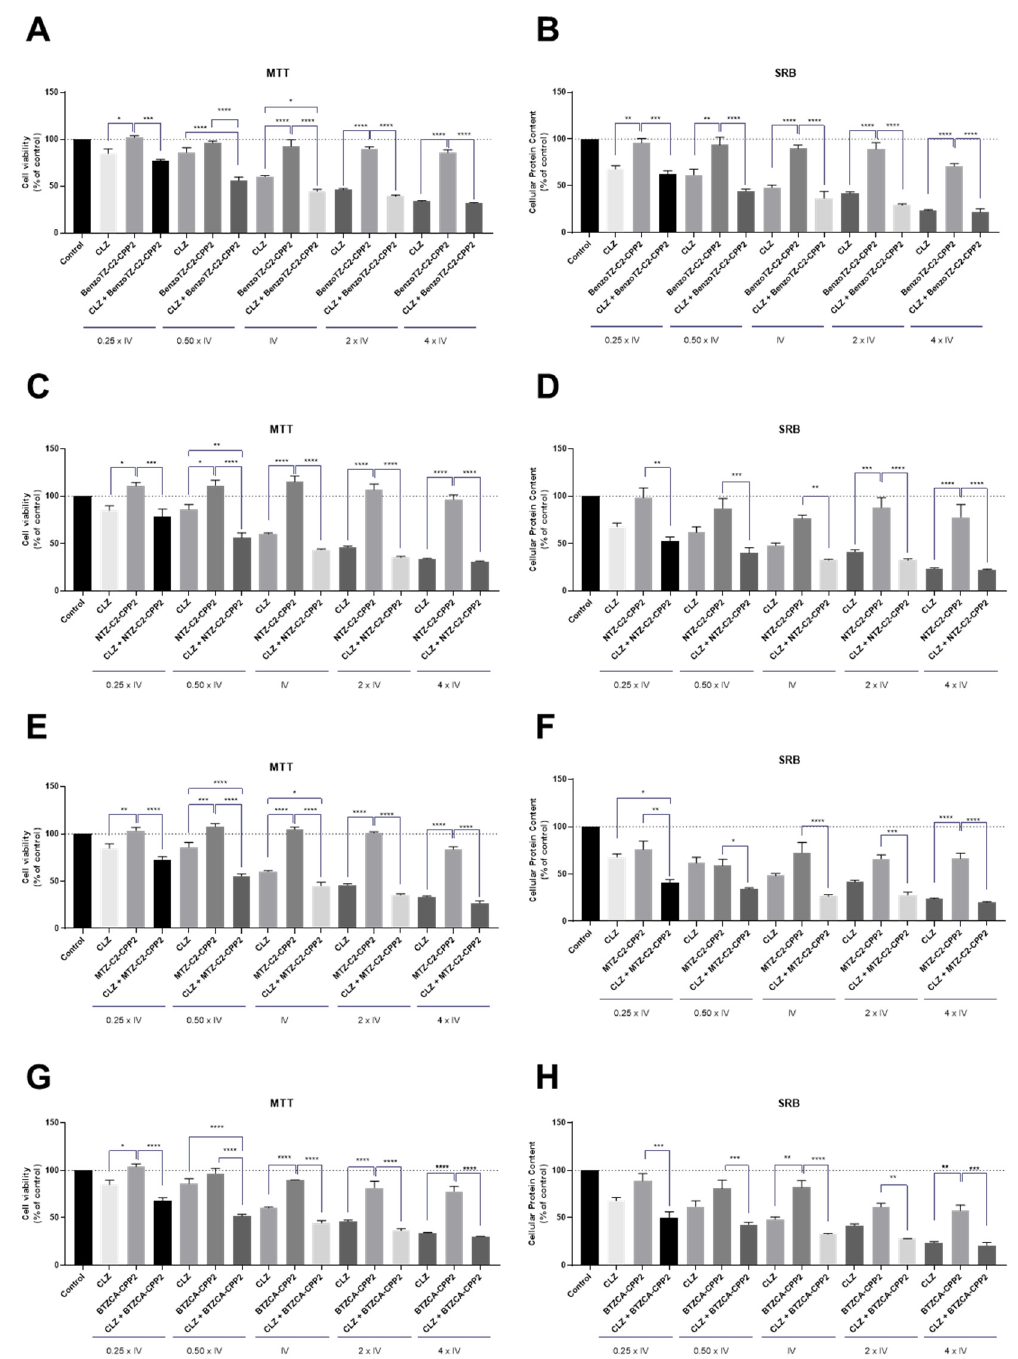
Figure 8. Cytotoxic effects of the combination of CLZ with ( A , B ) BenzoTZ-C2-CPP2, ( C , D ) NTZ-C2-CPP2, ( E , F ) MTZ-C2- CPP2 and ( G , H ) BTZCA-CPP2 on the viability ( right panel) and cell protein ( left panel) content of PC-3 cells. Cell viability and protein content were assessed by MTT and SRB assays, respectively, after 48 h of exposure to each treatment. Results are expressed in the percentage of cell viability relative to the untreated control cells. *, **, *** and **** indicate p < 0.05, p < 0.01, p < 0.001 and p < 0.0001, respectively, when compared to the control. All data are presented as the mean ± SEM of three independent